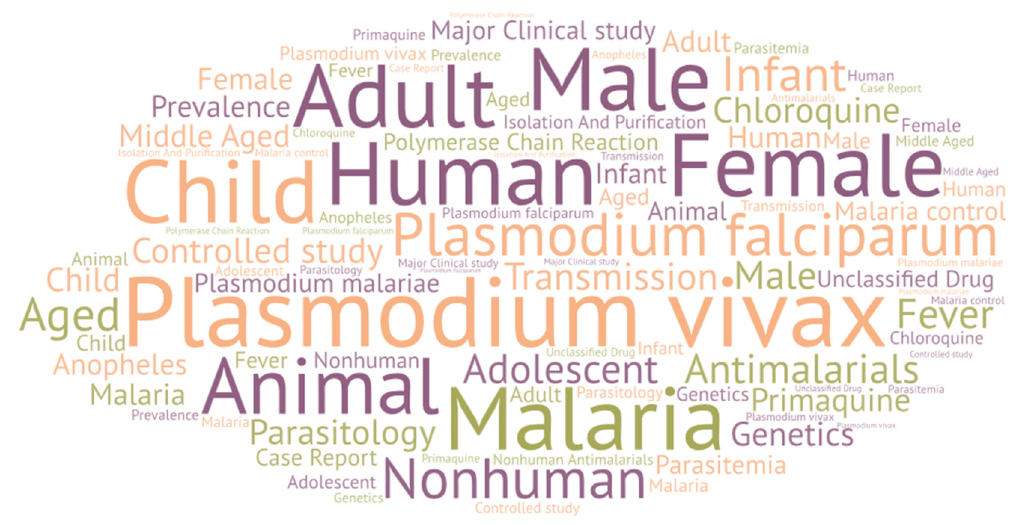
Figure 7. Word cloud with the main keywords.